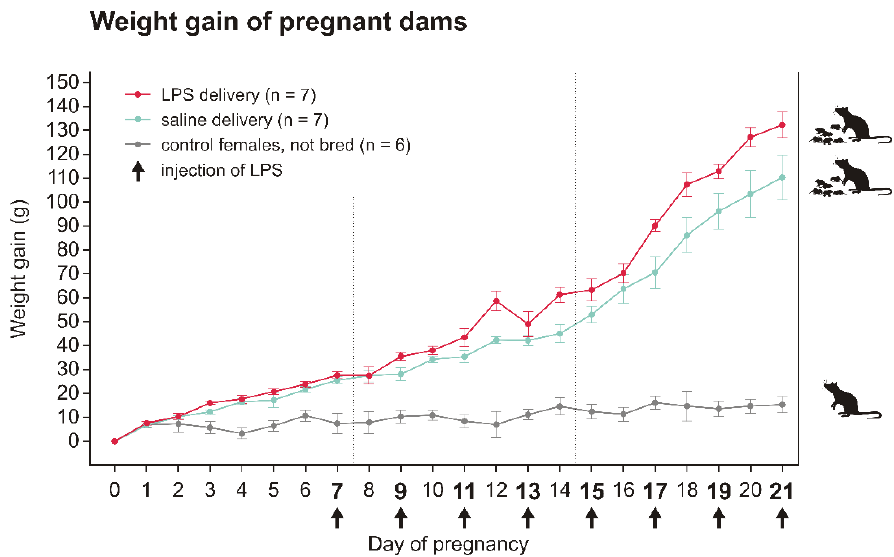
Figure A1. Pregnancy success. Weight gain of LPS- and saline-treated females in comparison to non-pregnant females. LPS administration did not negatively affect gaining of weight.